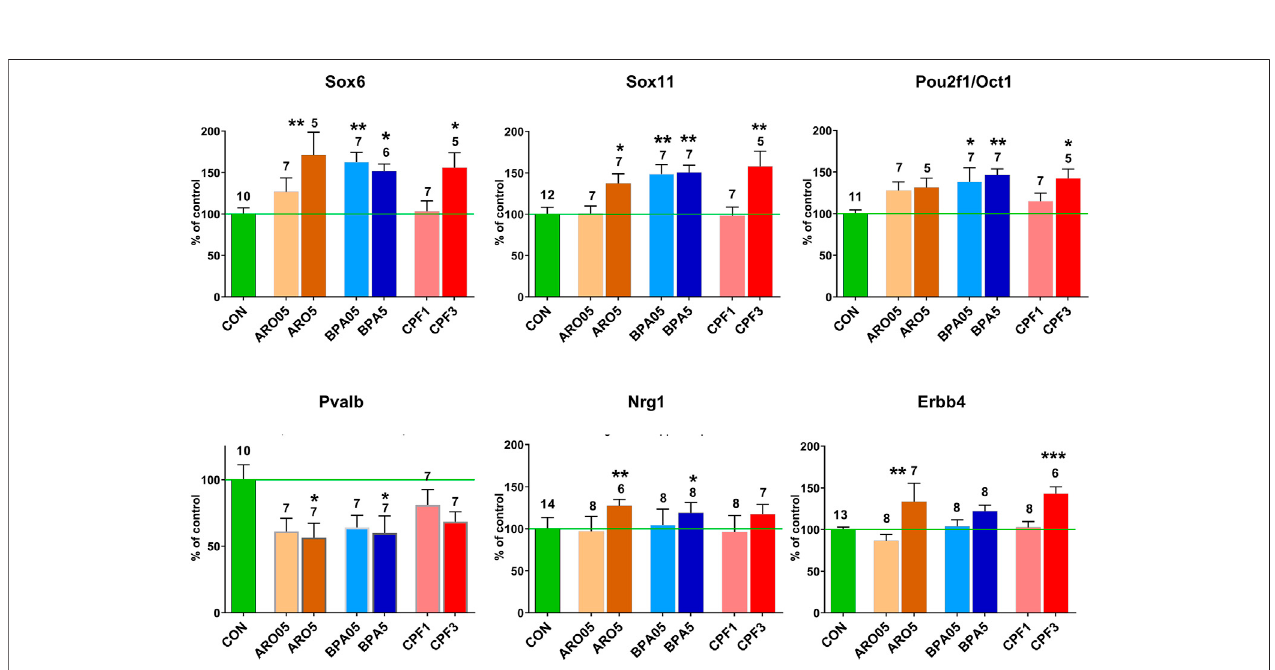
FIGURE 3 | mRNA levels in male hippocampus at postnatal day 6 after pre- and postnatal administration of Aroclor 1254 (ARO0.5: 0.5 mg/kg, ARO5: 5 mg/kg), bisphenol A (BPA0.5: 0.5 mg/kg, BPA5: 5 mg/kg), or chlorpyrifos (CPF1: 1 mg/kg, CPF3: 3 mg/kg). Quantitative RT PCR of hippocampus samples not used for transcriptomics. Mean ± SEM, number of samples (one/litter). Difference from control: * p < 0.05, ** p < 0.01, *** p < 0.001.